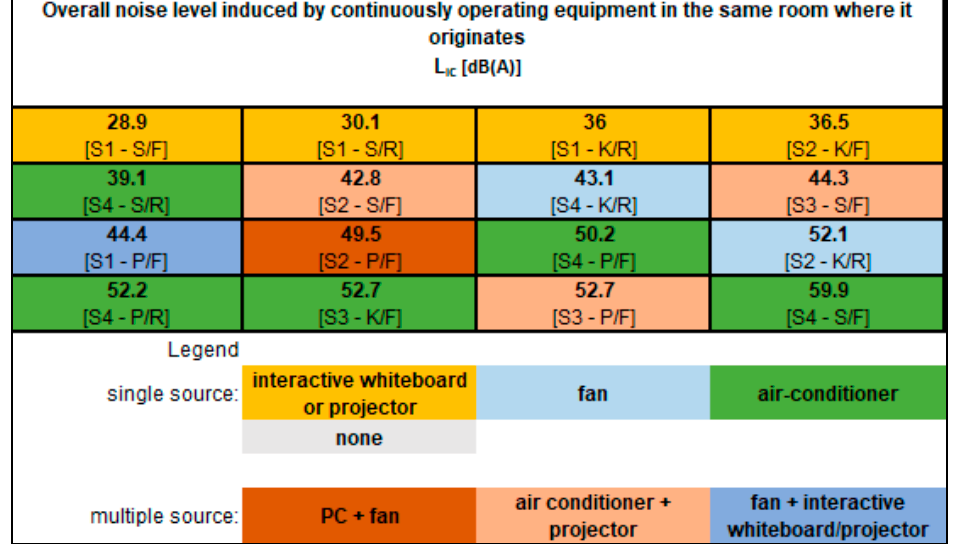
Figure 4. Overall noise level induced by continuously operating equipment in the same room where it originates carried out in scenarios S1, S2, S3, and S4, regarding noise due to sound sources inside the investigated room. Each box indicates the noise level of the source or multiple sources; colours correspond to different combinations of sound sources in the scenario under investigation, as shown by the legend: in square brackets, the scenario (e.g., “S1” for the classroom) and its location (e.g., “S/F” for the secondary school in Florence) are reported.